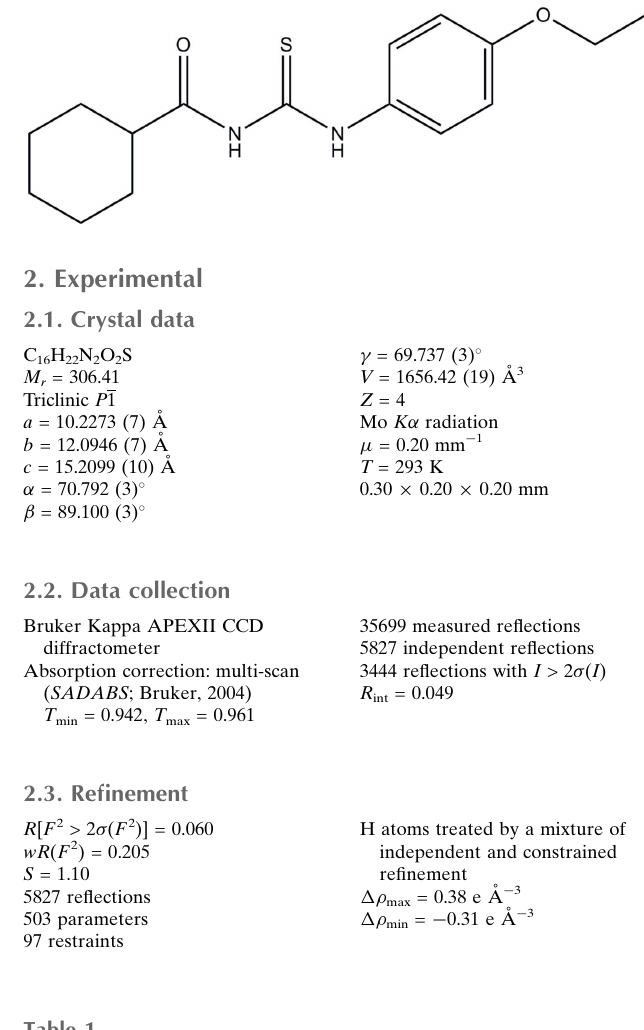
Hydrogen-bond geometry (A˚ , (cid:2)